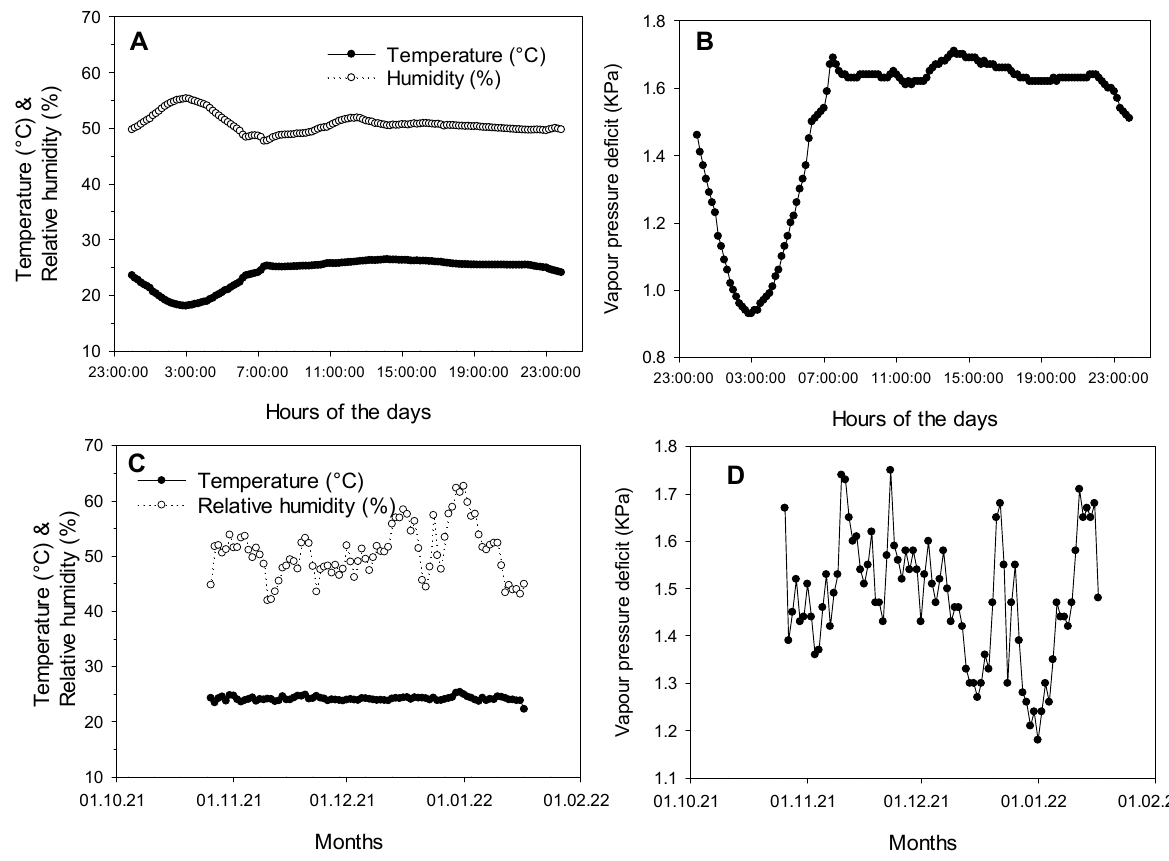
Figure 2. Daily averages of temperature and relative humidity ( A ), daily average vapor pressure deficit ( B ), and the temperature and relative humidity ( C ), and vapor pressure deficit ( D ) recorded along the experiment.